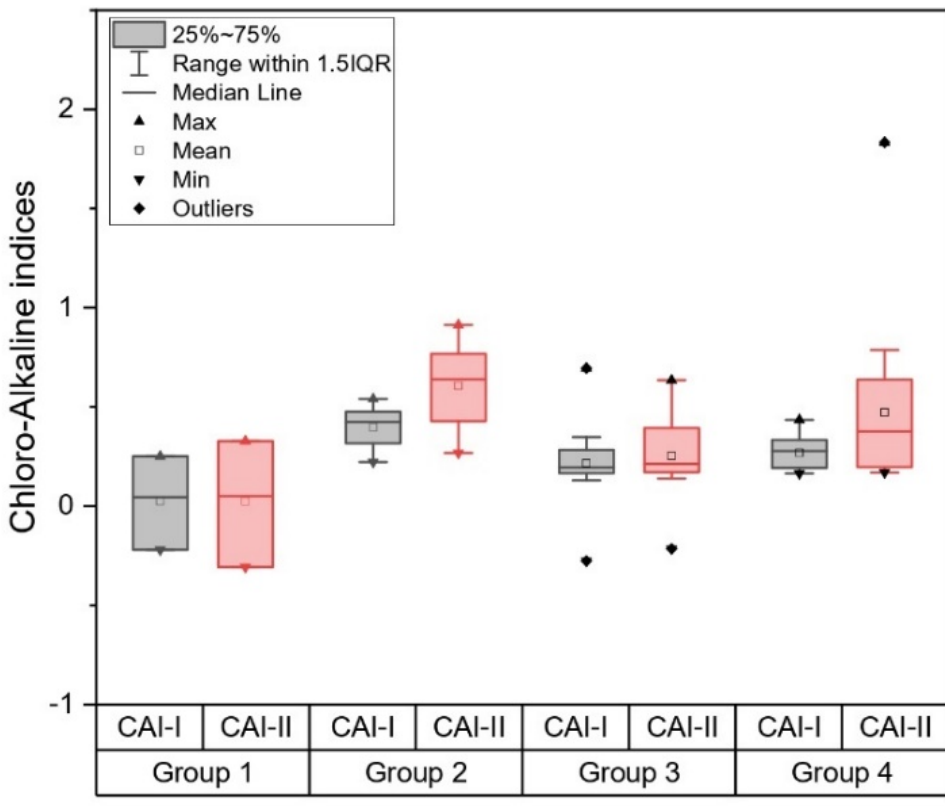
Figure 13. Chloro-alkaline indices for the four groups.